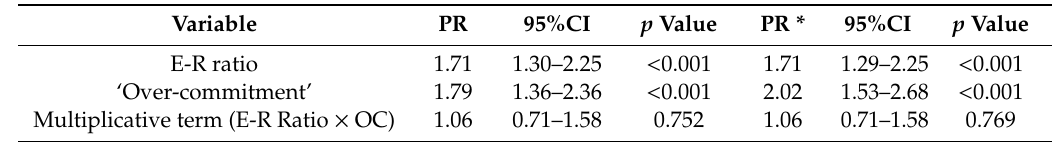
Table 4. Analysis de of the interaction of E–R ratio and ‘over-commitment’ with depressive episodes based on the multiplicative (product-term) criterion. ELSA-Brasil, 2012–2014.